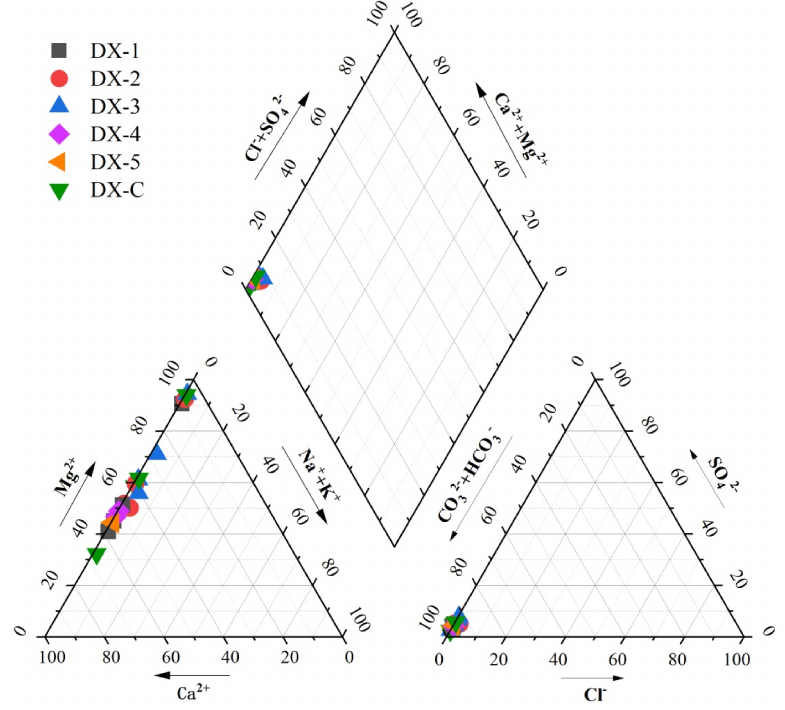
Figure 3. Dry season drip water Piper diagram of Daxiao